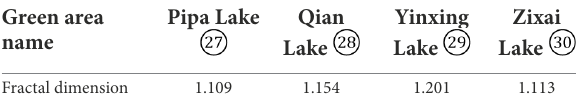
TABLE 7 Fractal dimension statistics of ecological landscape water body.